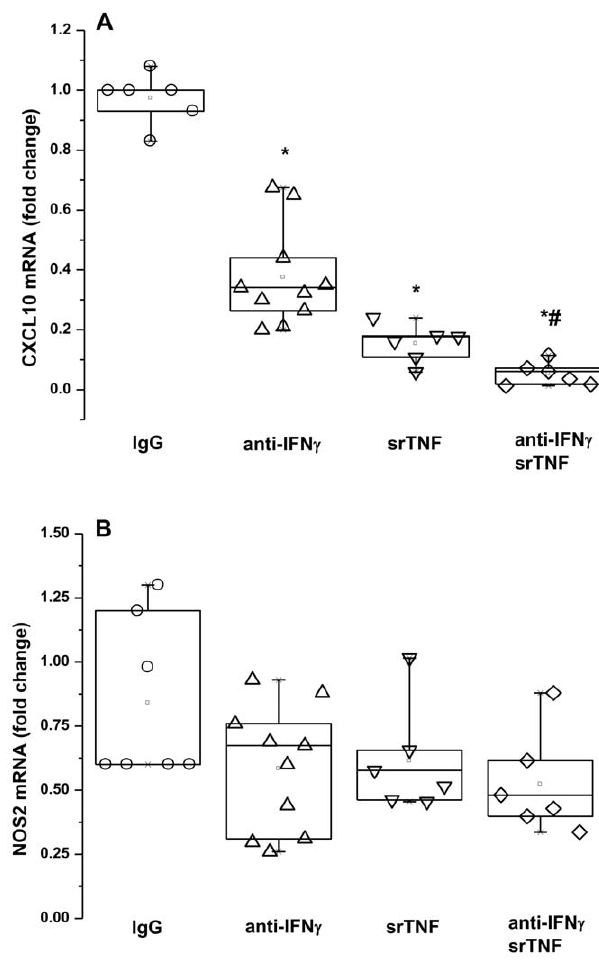
Figure 4. Anti-IFN c and TNF soluble receptor p75 strongly reduce epithelial CXCL10 mRNA expression but only partially attenuate epithelial NOS2 expression induced by T cells. HNEC were co-cultured with activated T cells in the absence or presence of anti-IFN c , TNF soluble receptor (srTNF) or an isotype-matched antibody (IgG). CXCL10 (A) and NOS2 (B) mRNA were measured by real-time PCR. Data are presented as fold change relative to those obtained in the absence of neutralizing agents. Shown are the boxplots with the 25 th , 50 th (median), 75 th percentiles, the mean (open square), the maximum and the minimum values. *p , 0.05 compared with isotype matched IgG treated cultures. # p , 0.05 compared with anti-IFN c and srTNF treated